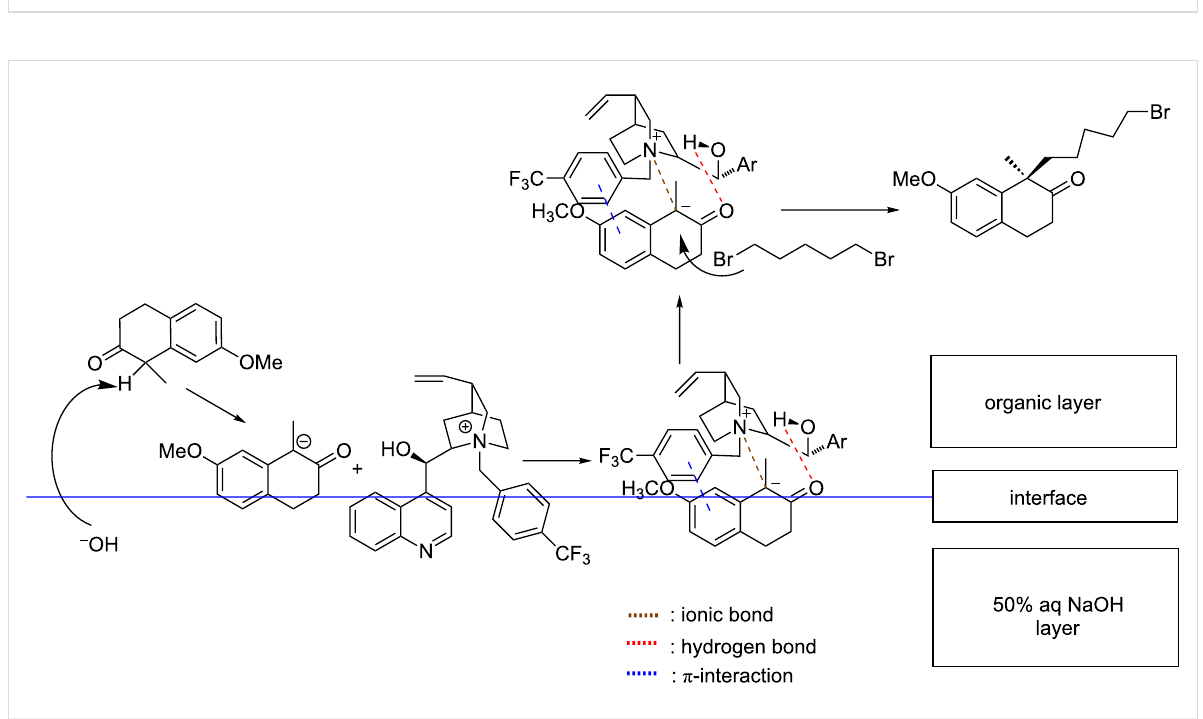
Scheme 3: The proposed catalytic mechanism of stereoselective alkylation.